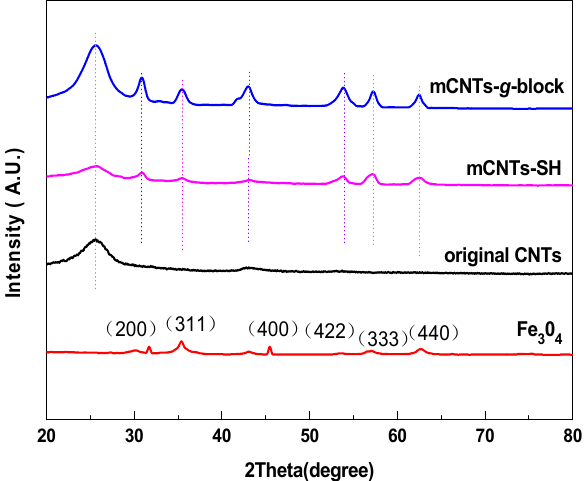
Figure 3. XRD of magnetically functionalized CNTs and Fe 3 O 4 .